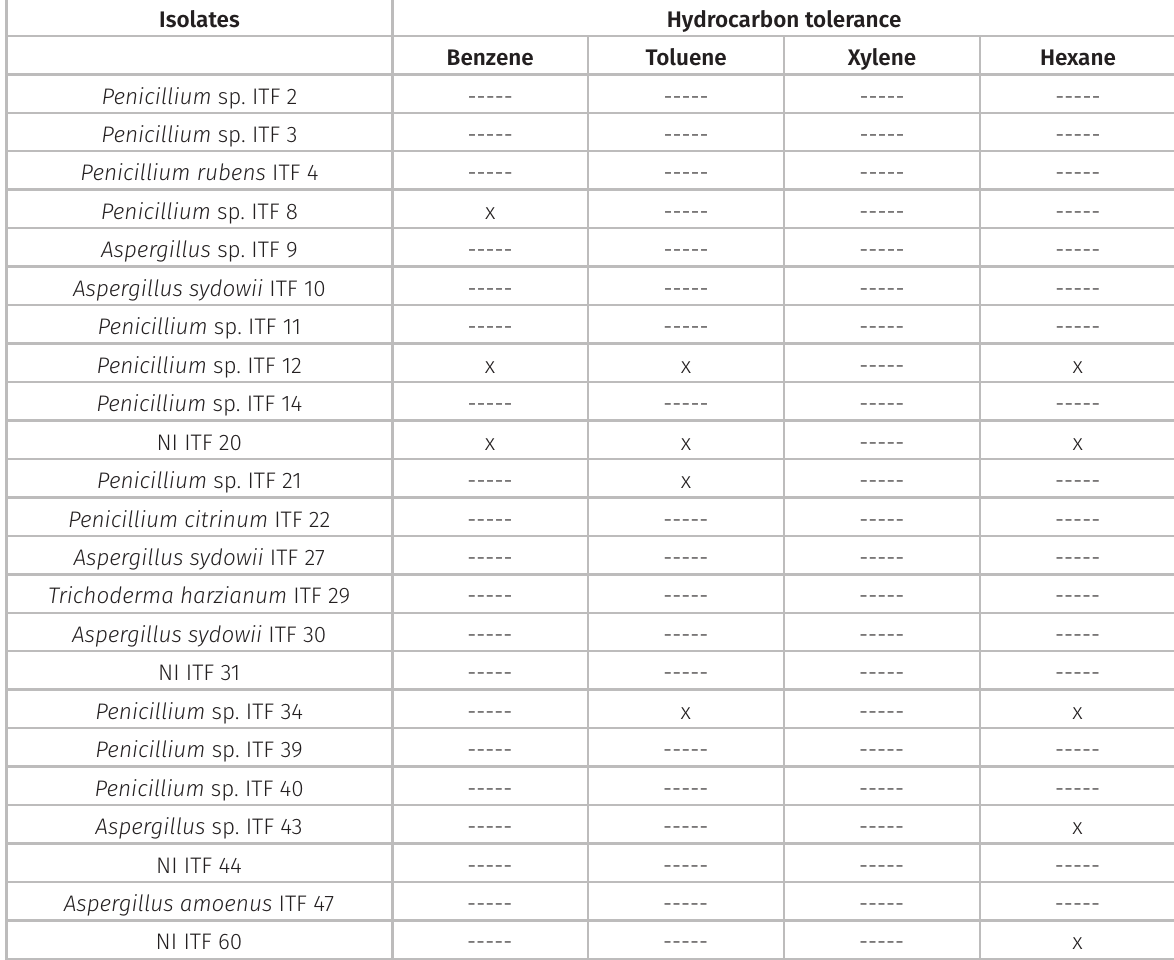
Table II. Tolerance capability of fungal species to